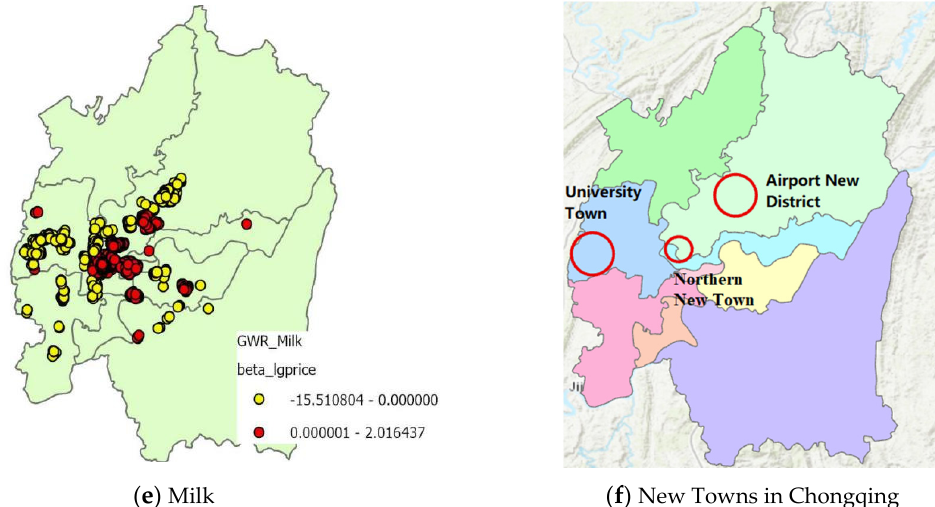
Figure 12. House price coeffects with the accessibility values of vegetables, fruit, seafood, meat, and milk in Chongqing.